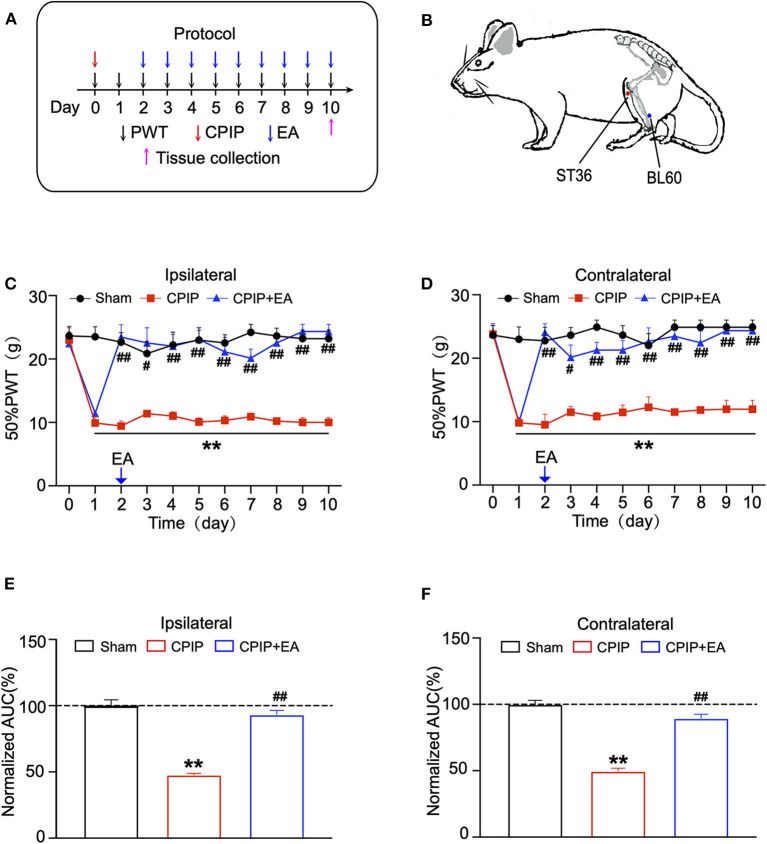
Evaluation of the anti-allodynic effects of electroacupuncture (EA) on CPIP model rats. (A) Experimental protocol for EA treatment. (B) Schematic picture of the locations of acupoints ST36 and BL60 on rat. (C) The effect of bilateral 100 Hz EA on 50% PWT of ipsilateral hind paws of CPIP rats. (D) The effect of bilateral 100 Hz EA on 50% PWT of contralateral hind paws of CPIP rats. (E) Summary of the normalized AUC as in (C). (F) Summary of the normalized AUC as in (D). n = 6 rats/group. **p < 0.01 vs. Sham group. #p < 0.05 and ##p < 0.01 vs. CPIP group. One-way ANOVA or two-way ANOVA followed by Tukey post-hoc test was used for statistical analysis.